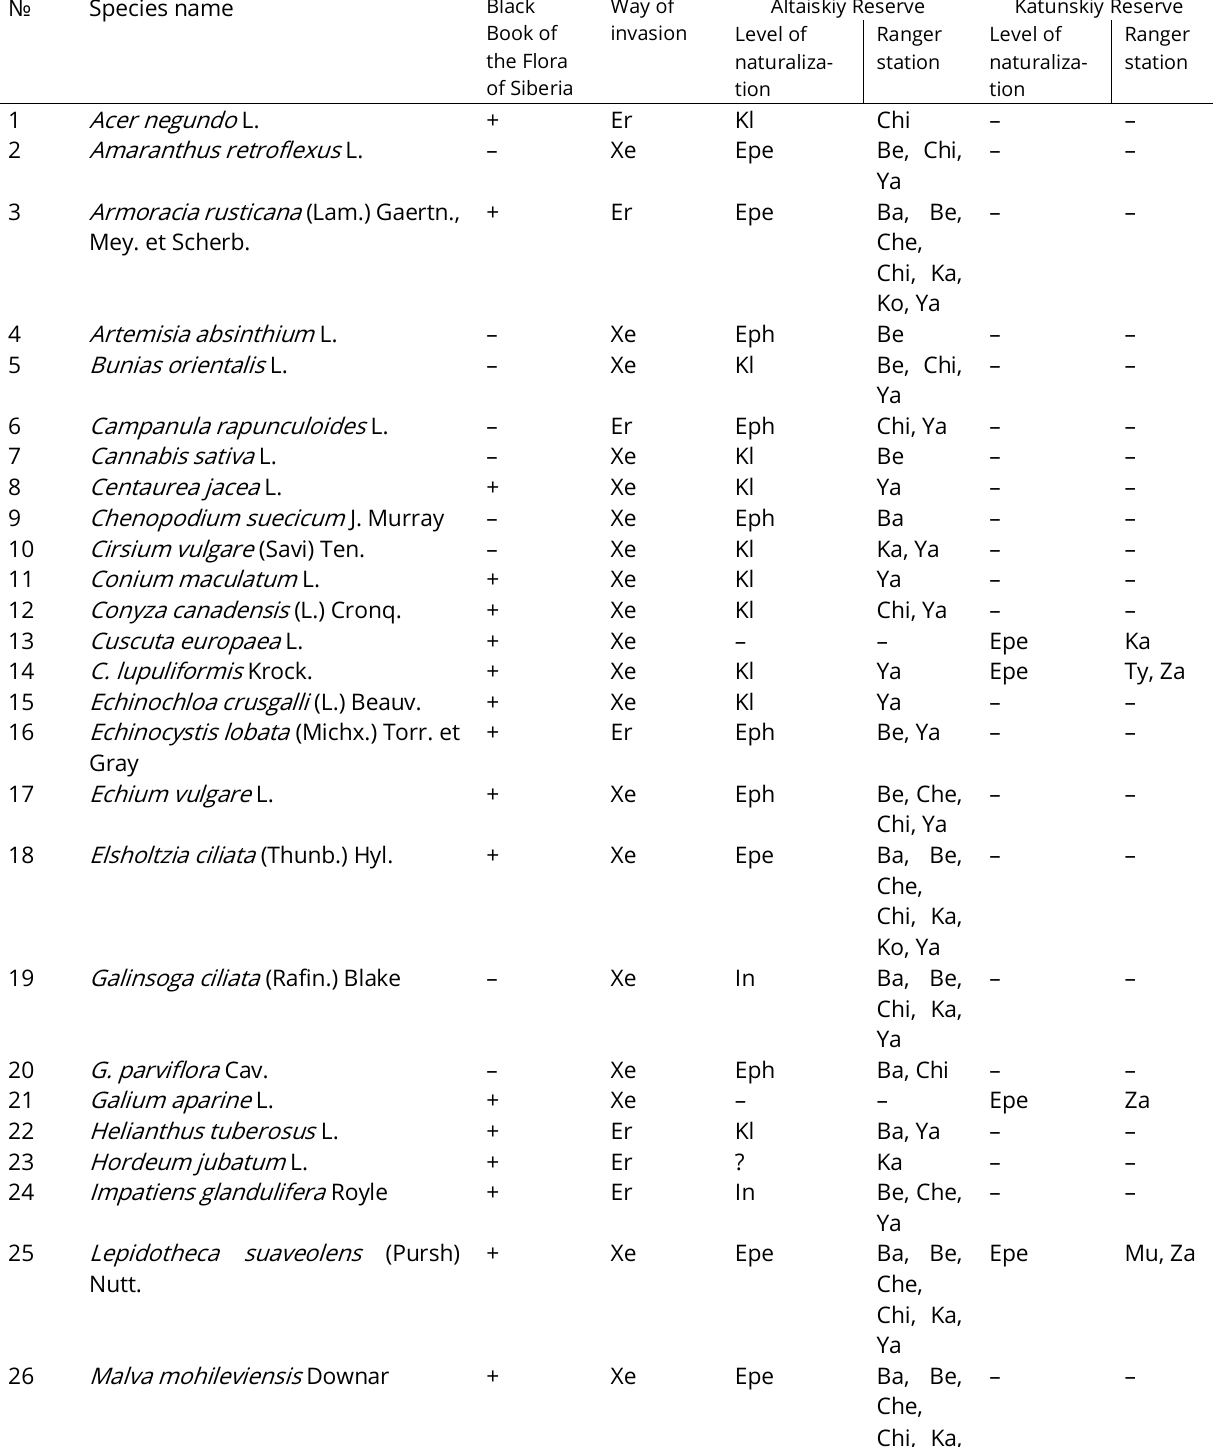
Table1. Invasive and potentially invasive plant species in the Altaiskiy and Katunskiy Reserves of the Altai